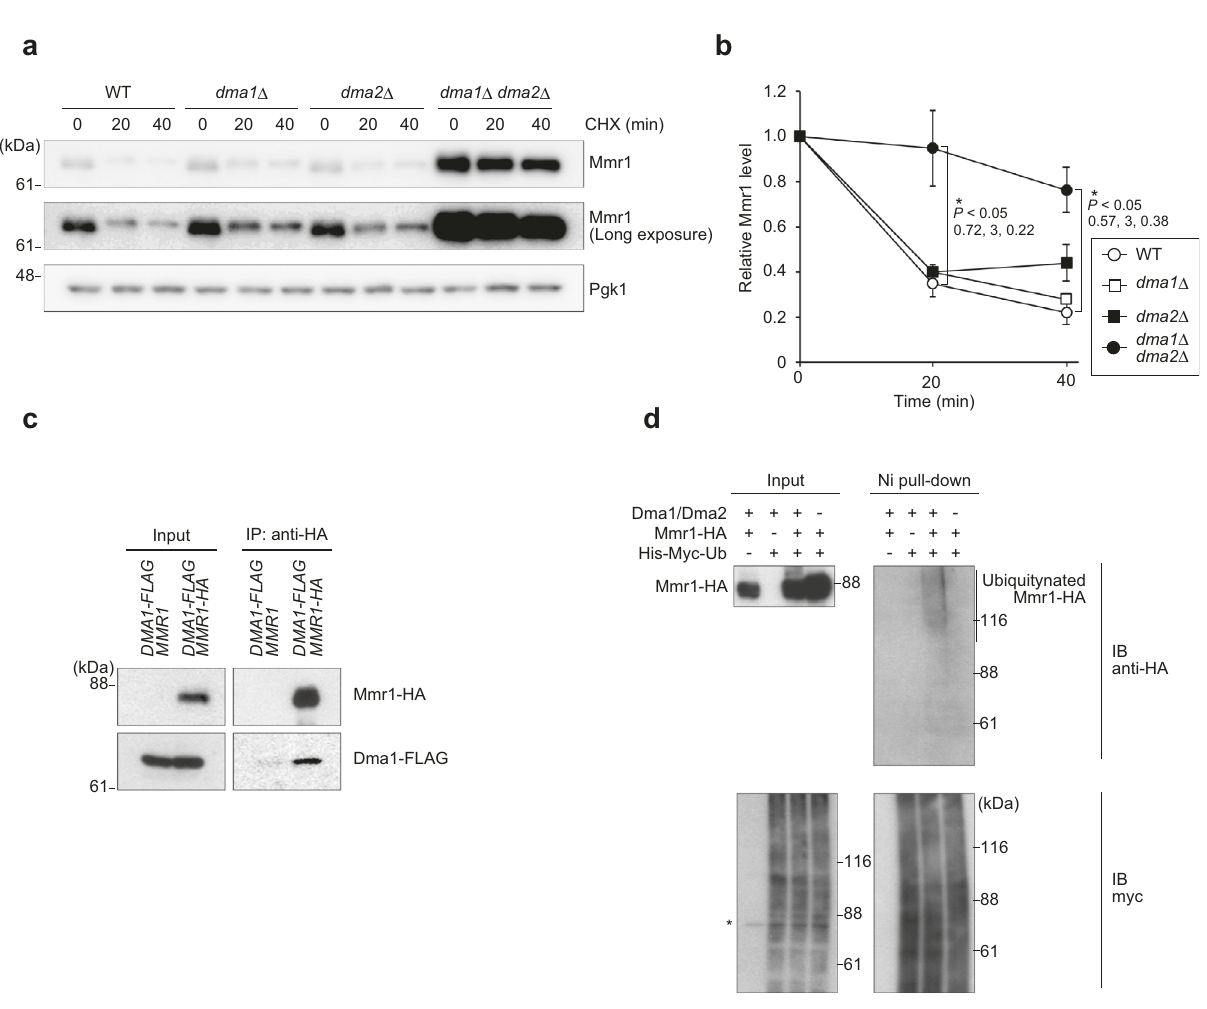
Fig. 2 Dma1 and Dma2 are involved in Mmr1 turnover. a W303-1a (WT), YTK5414 ( dma1 Δ ), YTK5415 ( dma2 Δ ), and YTK5416 ( dma1 Δ dma2 Δ ) cells grown to log phase in YPD medium were treated with cycloheximide (CHX) and harvested. Their total lysates were prepared and subjected to immunoblot analysis with anti-Mmr1 or, to demonstrate uniform loading, anti-Pgk1 antibody. b Mmr1 level was measured, normalized with that of Pgk1, and shown as a relative value to that at 0 min. Values represent the mean ± SE from three independent experiments. Signi fi cance was tested by one-way analysis of variance (ANOVA) with Dunnett ’ s comparison (values of con fi dence intervals, degrees of freedom, and F are indicated). c YTK5423 ( cim3-1 DMA1-FLAG ) and YTK5425 ( cim3-1 DMA1-FLAG MMR1-HA ) cells were grown to log phase in YPD medium at permissive temperature (25 °C), further incubated for 2 h at the restrictive temperature (37 °C), and subjected to co-immunoprecipitation analysis using anti-HA antibody. The input and immunoprecipitated fraction were then subjected to immunoblot analysis with anti-HA or anti-FLAG antibodies. Similar results were obtained from two independent experiments. d YTK3487 ( cim3-1 MMR1-HA ), YTK6168 ( cim3-1 His-Myc-ubiquitin ), YTK5810 ( cim3-1 His-Myc-ubiquitin MMR1-HA ), and YTK5893 ( cim3-1 His-Myc-ubiquitin MMR1-HA dma1 Δ dma2 Δ ) cells were grown to log phase in YPD medium at permissive temperature (25 °C), further incubated for 90 min at the restrictive temperature (37 °C), and subjected to pull-down assay using Ni 2 + -agarose beads. The input and the pull-down fractions were then subjected to immunoblot analysis with anti-Myc or anti-HA antibodies. Similar results were obtained with two independent experiments. *, non- speci fi c